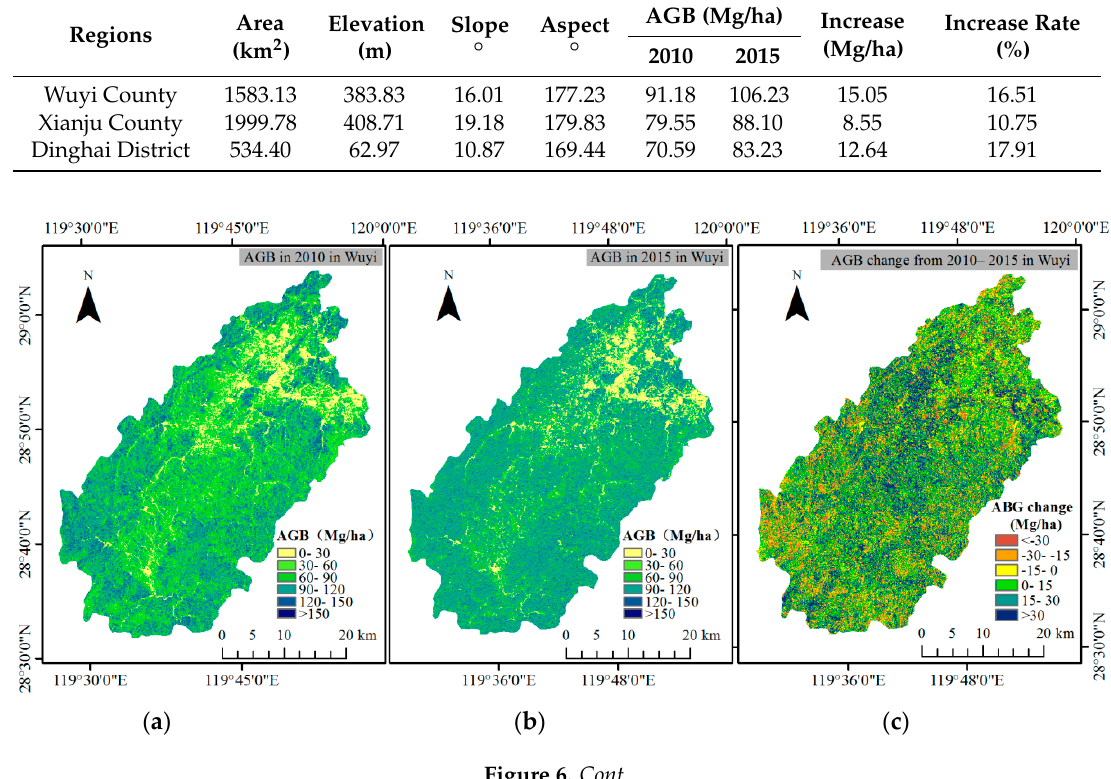
Table 3. Basic information and AGB change in three regions.